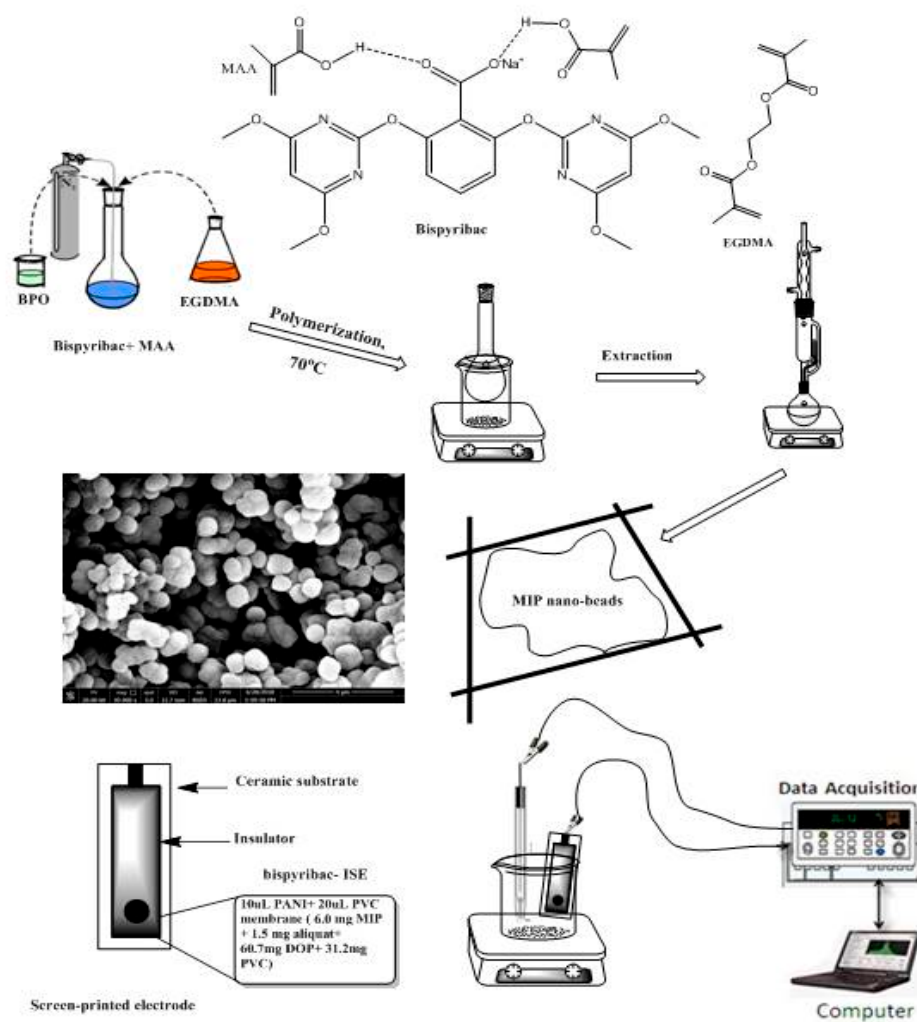
Figure 7. Schematic representation for MIPs synthesis and screen- printed electrode.